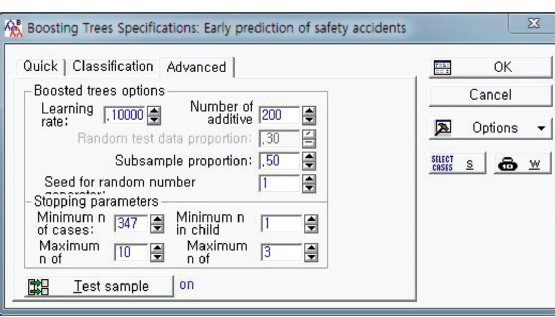
Figure 2: Parameter setting for the SGB